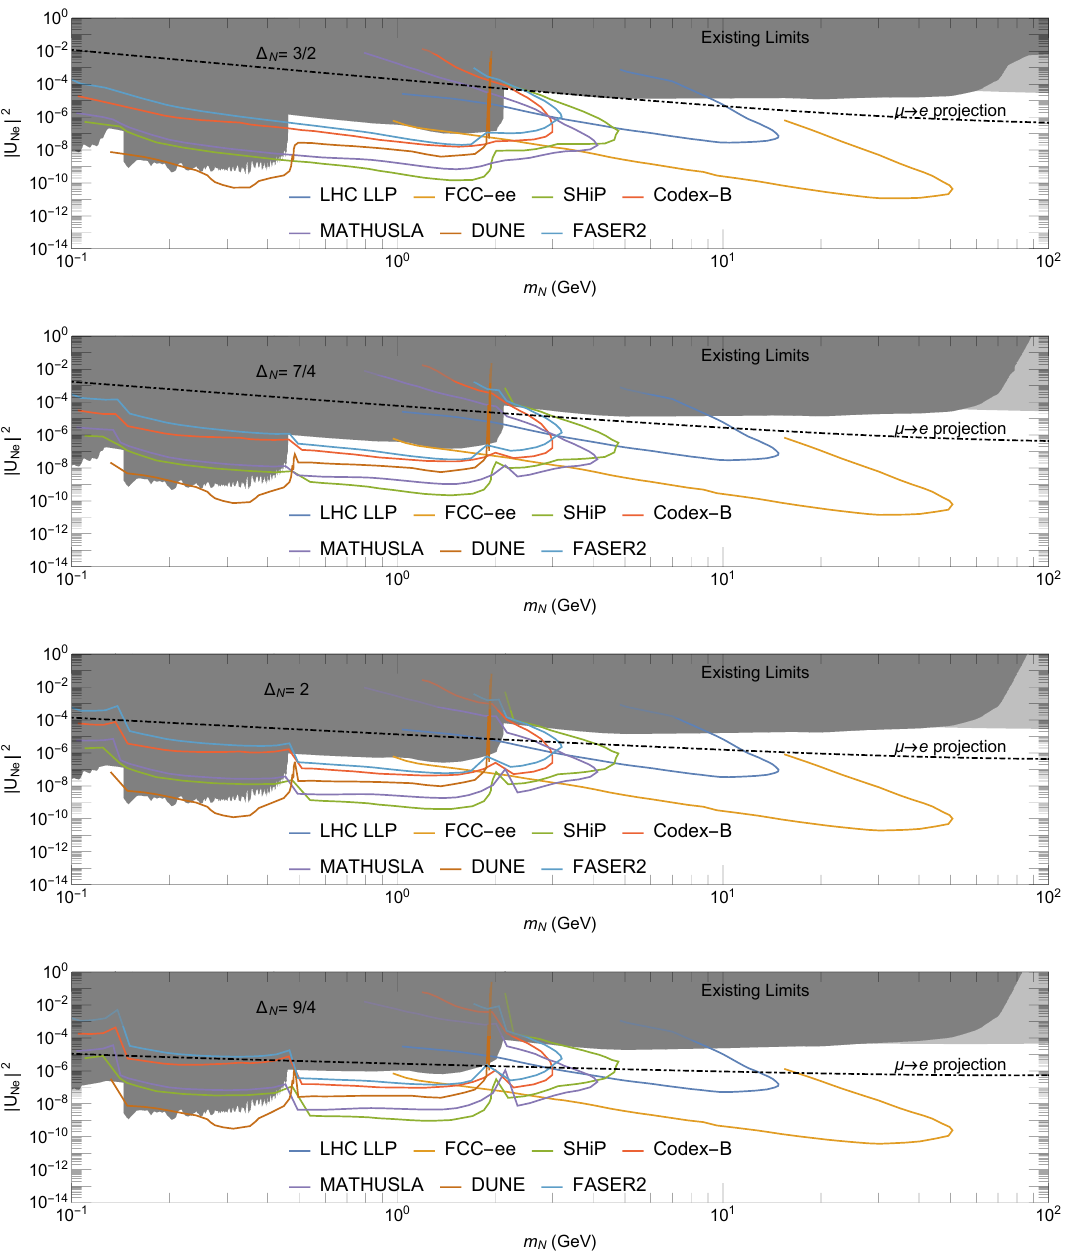
Figure 8 . Future projections for constraints on the composite neutrino parameter space, in the singlet neutrino mass m -mixing angle squared | U 2 plane, for different benchmark choices of N Ne | the scaling dimensions ∆ . The current limits detailed in figure 7 are shaded in gray. Details of the N future projections can be found in the text. The flavor dependent current limit and future projec- tions from the µ - e conversion experiments are in light gray shade and dot-dashed line,